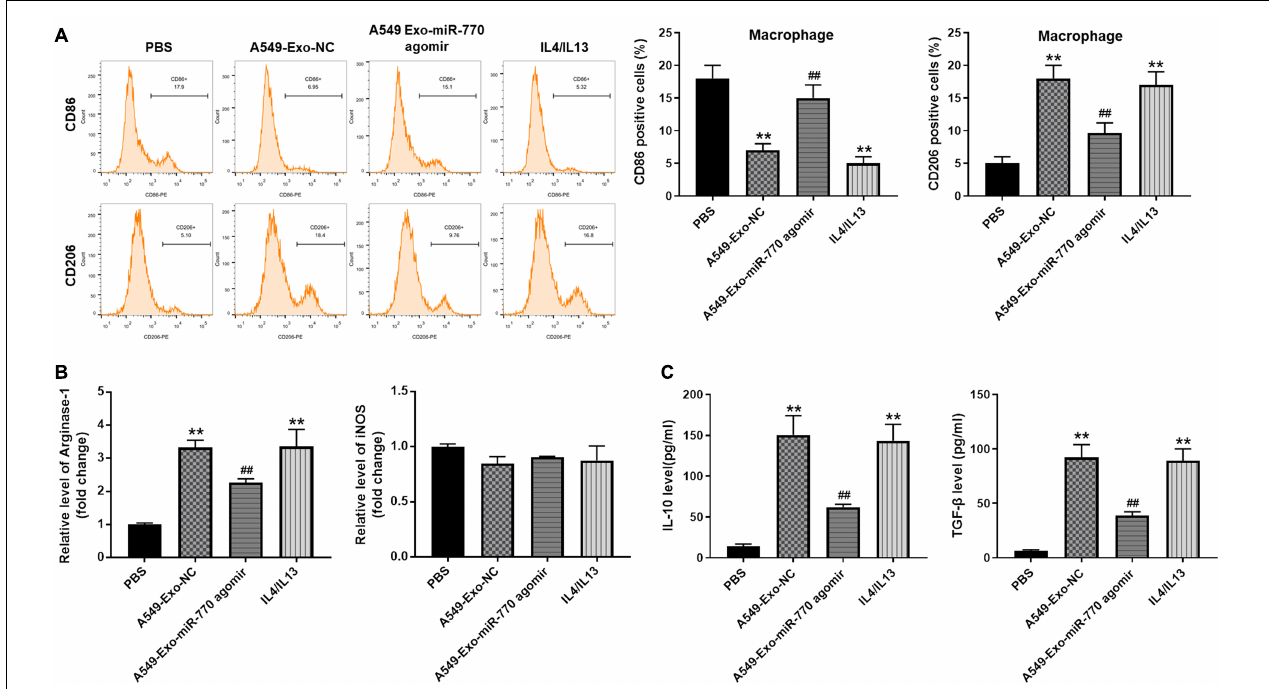
FIGURE 5 | Exosomal miR-770 inhibited M2 polarization in macrophages. (A) Macrophages were co-cultured with A549-Exo-NC, A549-Exo-miR-770 agomir or 20 ng/ml IL-4/IL-13 for 24 h. Then, the rate of CD86 or CD206 distribution in macrophages was tested by flow cytometry. (B) The levels of Arginase-1 and iNOS in macrophages were tested by RT-qPCR. (C) The levels of TGF- β and IL-10 in supernatants of macrophages were detected by ELISA. N = 3; ** P < 0.01 compared to PBS, ## P < 0.01 compared to A549-Exo-NC.